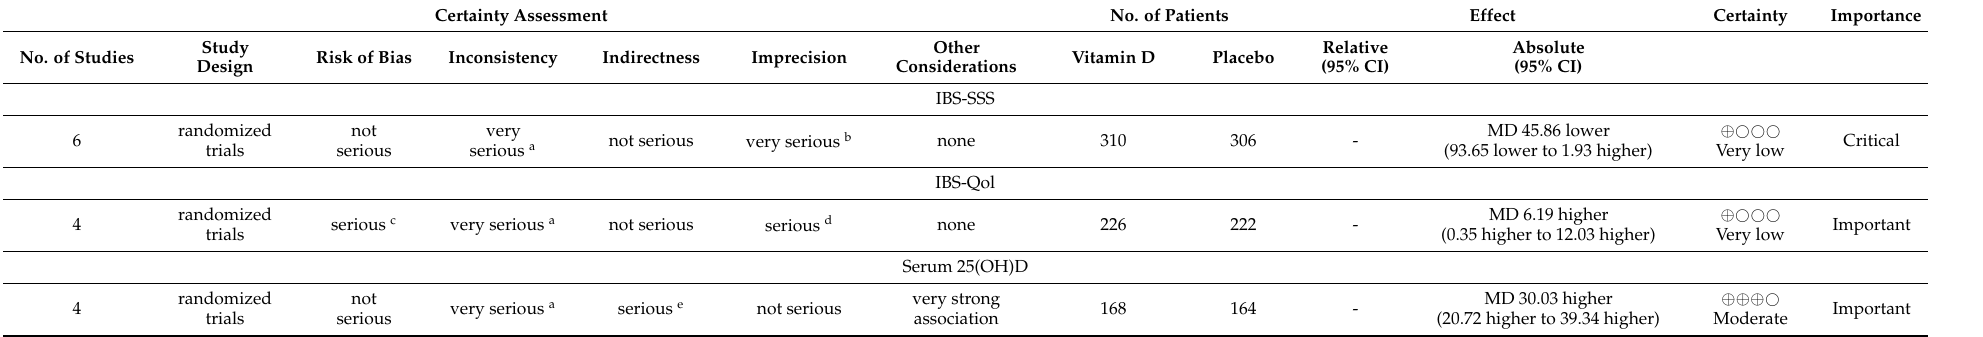
Table 3. GRADE evidence profile: vitamin D compared to placebo for